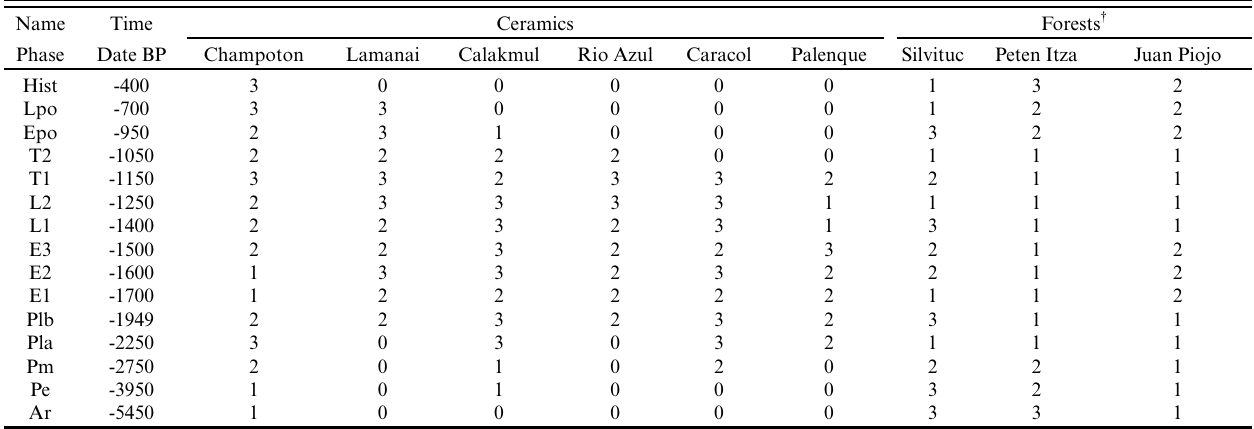
Table 2 . Integrated History and Future of People on Earth (IHOPE)–Maya distribution analysis data. IHOPE-Maya subperiods (see Table 1), dates BP, elite ceramic interactions, and forest cover.